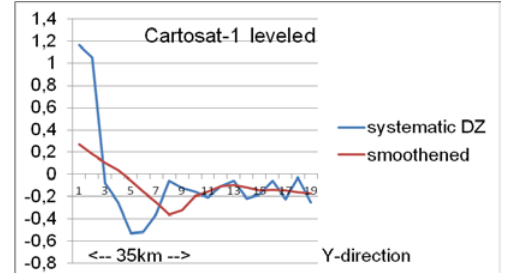
Fig. 20. Systematic height errors in Y-direction, Warsaw, Leveled Cartosat-1 DSM against reference